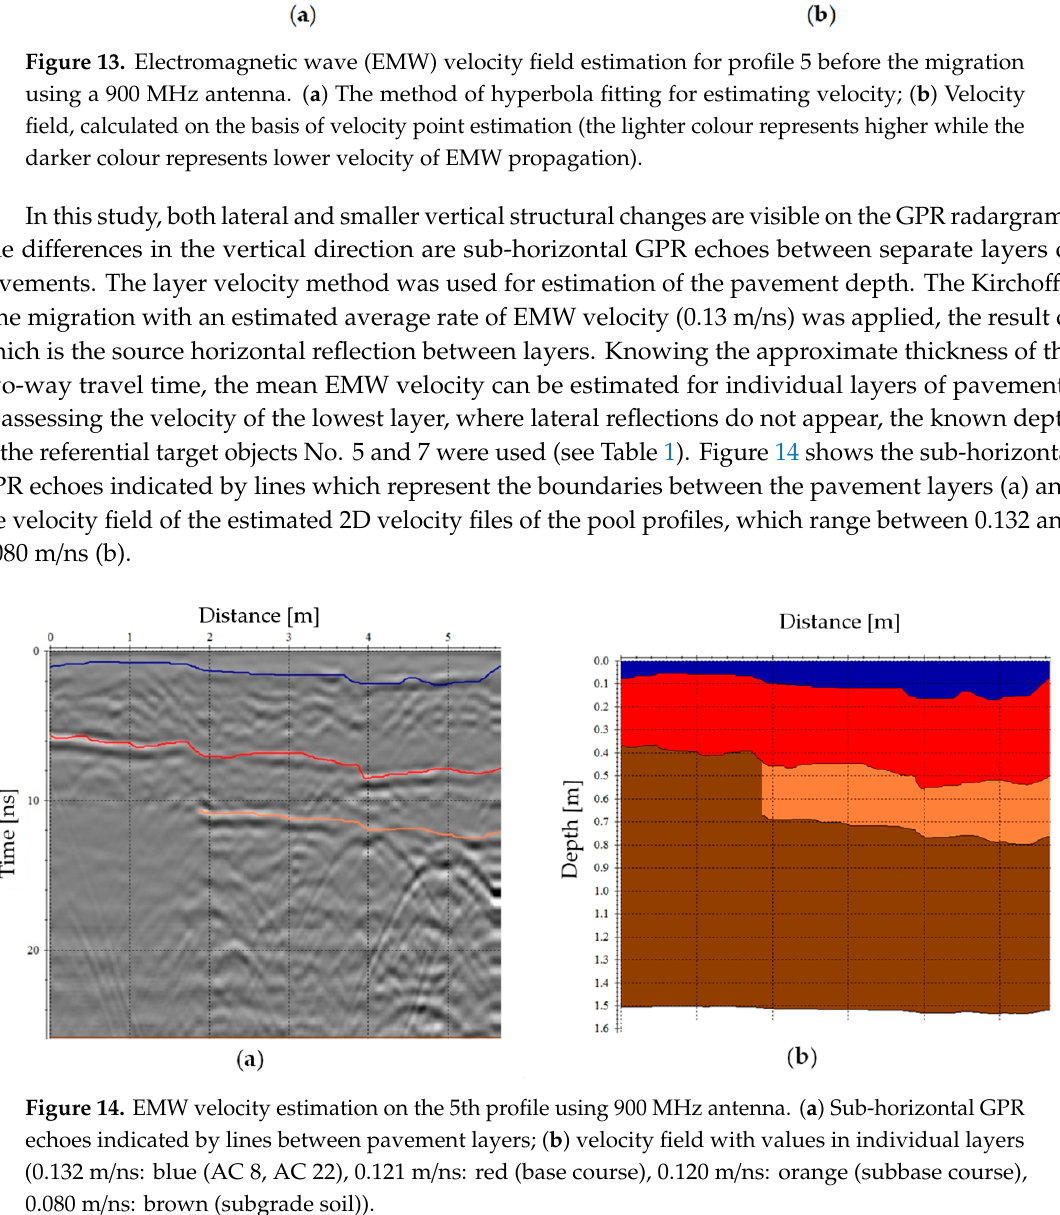
Figure 15. Time-to-depth conversion of profile 5 using a 900 MHz antenna with the velocity field calculated on the basis of the layer velocity method . Figure 16 shows a time to depth conversion of the velocity field obtained with the hyperbola fitting method. Certain discontinuity is clearly visible (red square) on part of the GPR profile. This indicates the incorrect selection of the EMW velocity (Figure 13). The positions and the depths of three distinct reflections (the same as in Figure 15) of the buried infrastructure are marked.